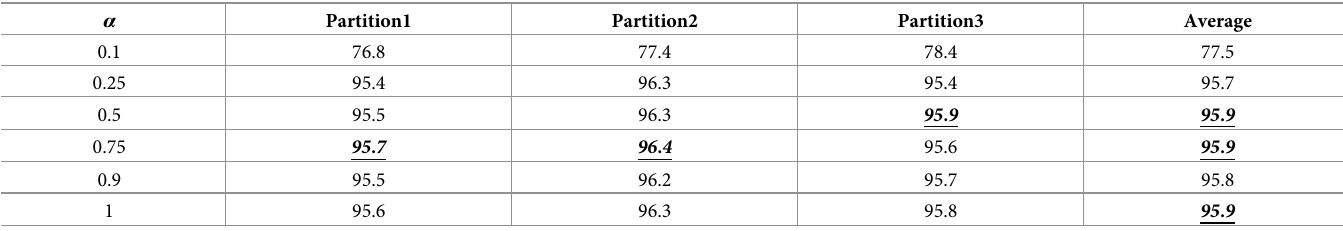
Table 3. The effect of different combinations of α and γ on hmdb-51 about accuracy. α = 0.50 & γ = 0.50 α = 0.5 & γ = 0.75 α = 0.50 & γ = 2.00 α = 0.50 & γ = 5.00 α = 0.75 & γ = 3.00 α = 0.75 & γ = 5.00 α = 0.90 & γ = 10.0